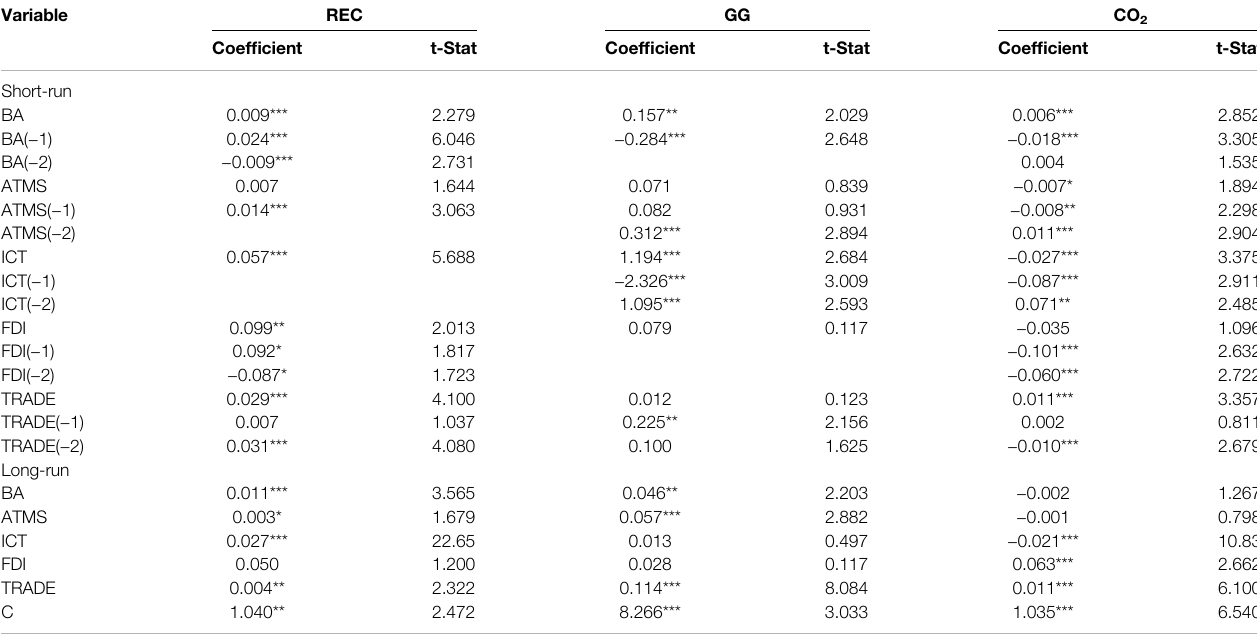
TABLE 3 | Short and long-run estimates of renewable energy consumption, green growth, and CO 2 emissions. Variable